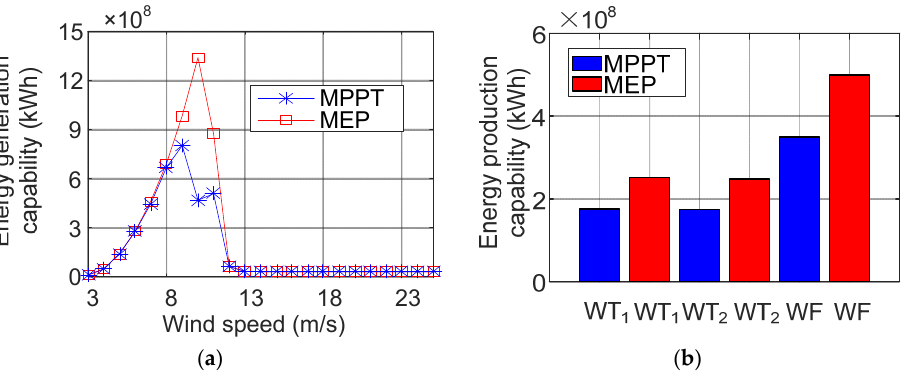
Figure 19. Comparison of: ( a ) energy production of the wind farm at constant wind direction of 270° without wind speed and direction distribution; ( b ) comparison of the energy production of WT 1 , WT 2 , and the wind farm at the real wind speed and direction distribution between the MPPT method and the proposed MEP method.